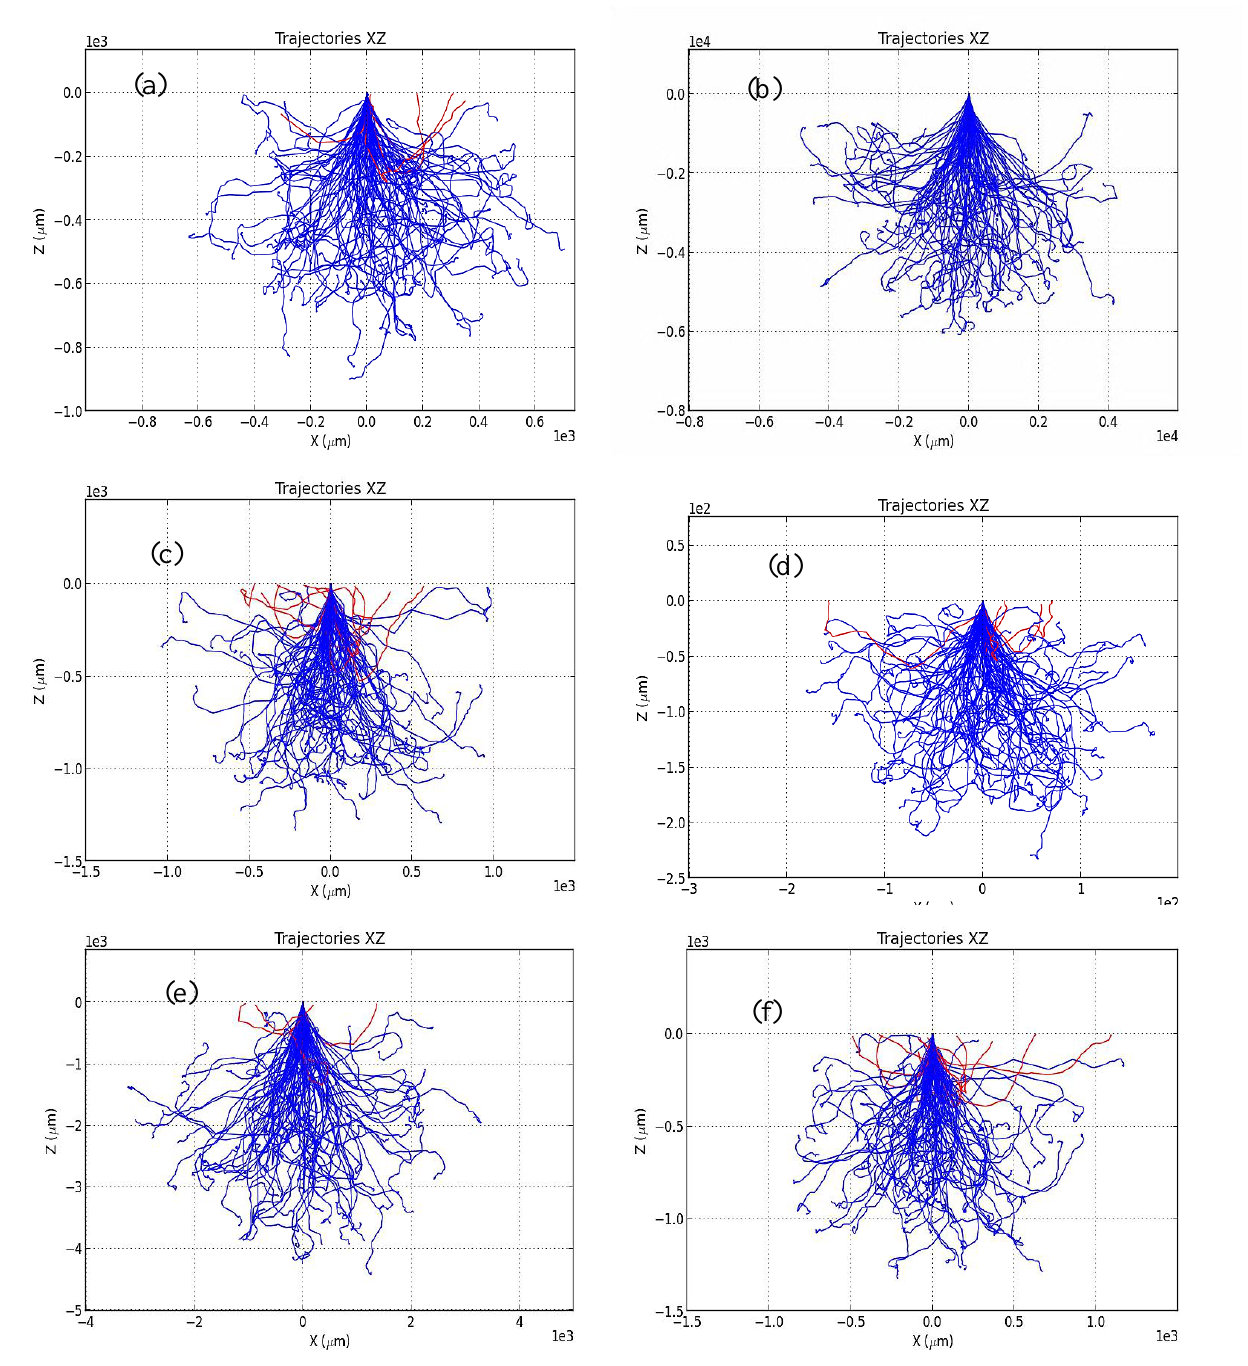
Fig.5: The trajectories of (a) 39 Ar, (b) 60 Co, (c) 125 Sb, (d) 147 Pm, (e) 154 Eu and (f) 204 Tl respectively beta particles into silicon carbide with the beam entering a slab. The blue lines: absorbed within the sample, the red lines: backscattered (beta particle exits from the same surface as it